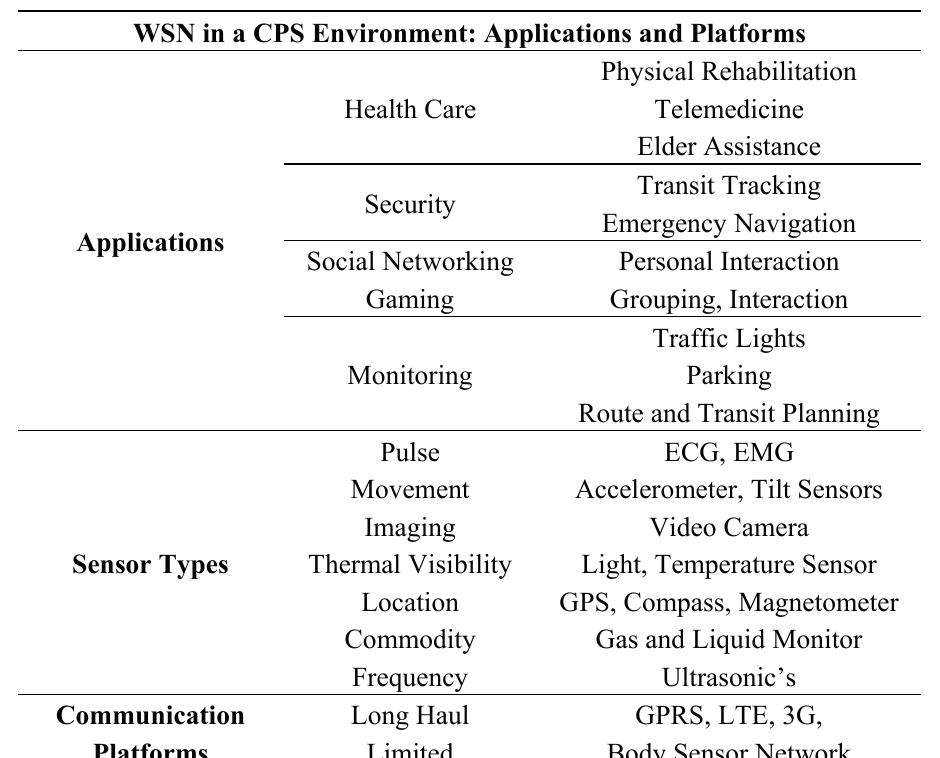
Table 4. Applications highlights of sensing plane in cyber physical sensor